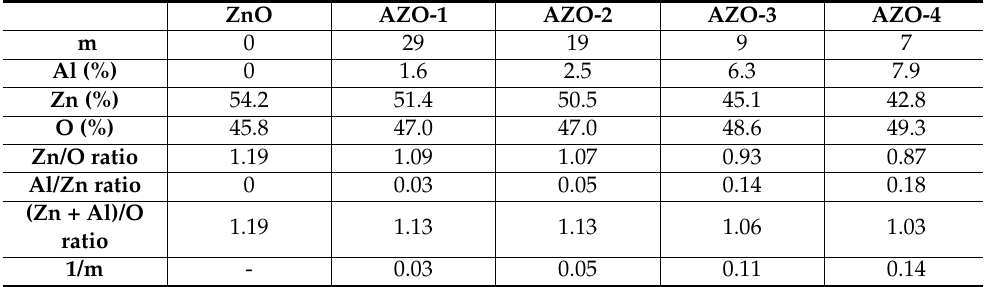
Table 2. Values of m (DEZ + H 2 O → ZnO) cycles and elemental composition of thin ZnO and AZO layers obtained by the ALD method on silicon substrates. ZnO AZO-1 AZO-2